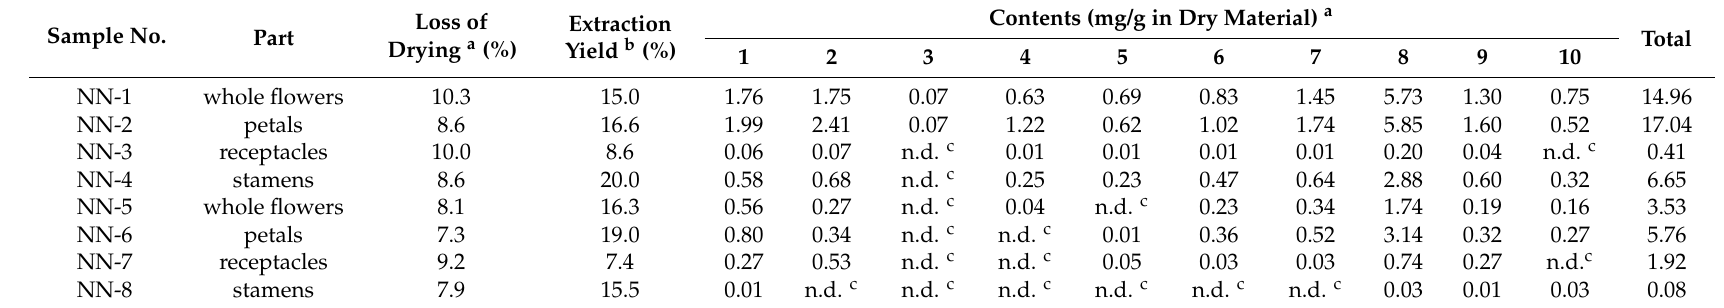
Table 5. Contents of alkaloids ( 1 – 10 ) in the methanol extracts from lotus